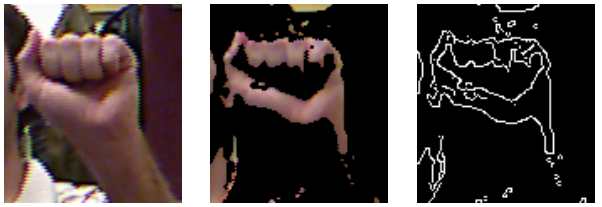
Figure 4. Original image ( left ); masked image ( middle ); edge image ( right